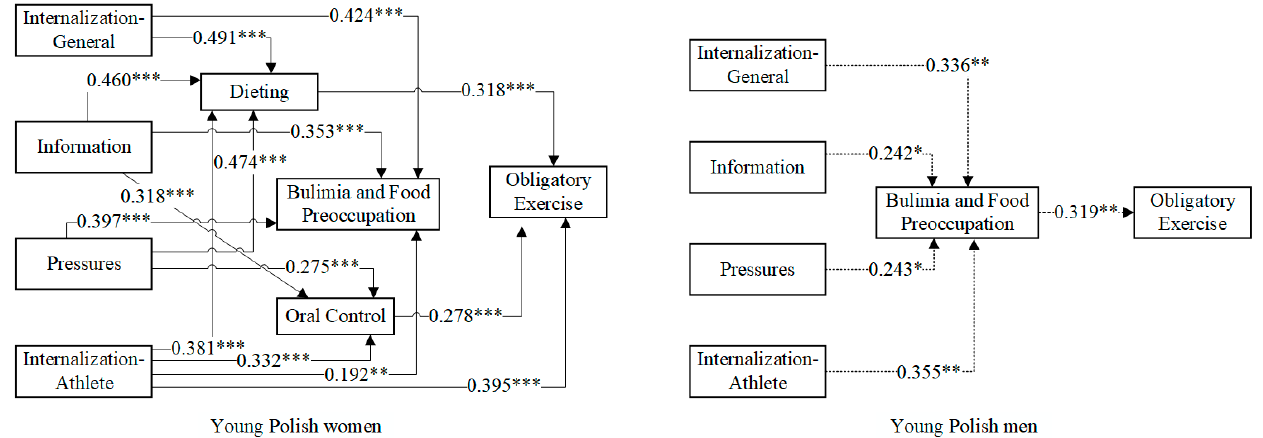
Figure 2. Sociocultural (Internalization—General, Information, Pressures, and Internalization—Athlete) and eating attitude (Dieting, Bulimia and Food Preoccupation, and Oral Control) predictors of obligatory exercise among young Polish men and women (n = 265). Note: Non-standardized estimates are presented—* p < 0.05, ** p < 0.01, *** p < 0.001—to improve the readability of the presentation; only paths with significance levels <0.05 were retained.